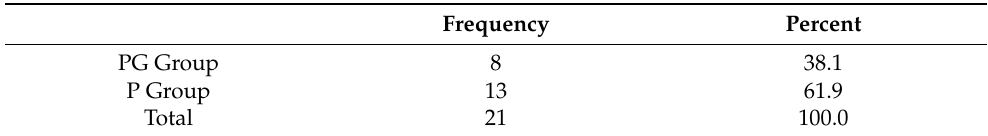
Table 1. The two groups of subjects.